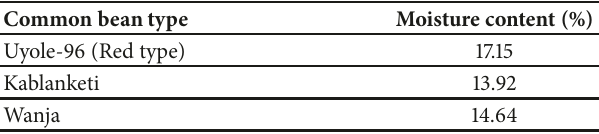
Table 1: Moisture content experimental results.